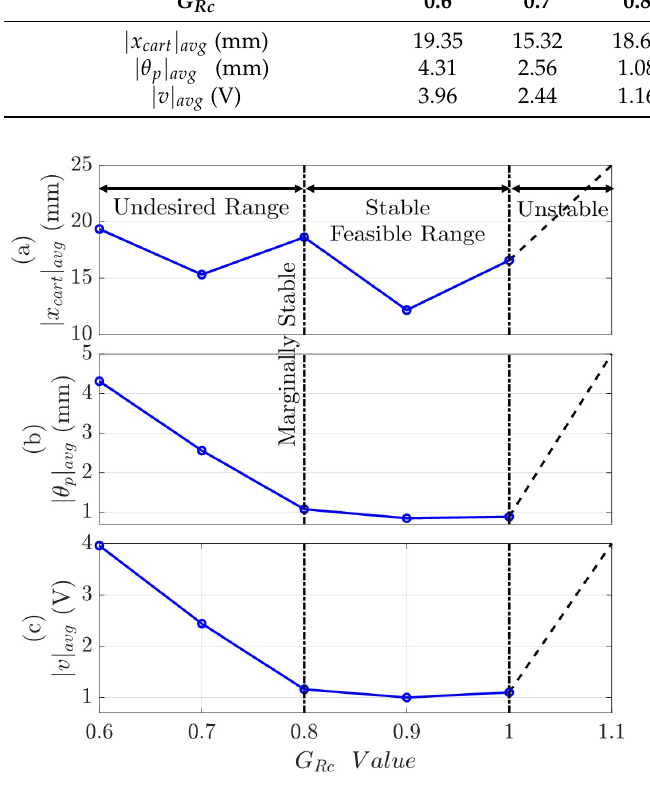
Figure 9. LQR c tuning data